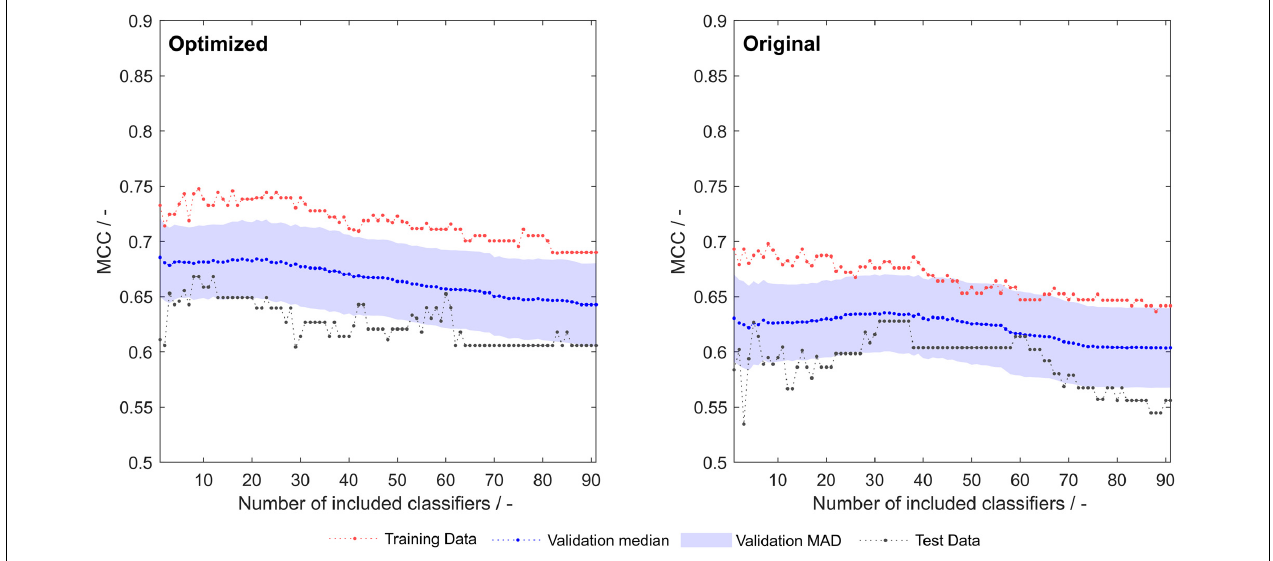
FIGURE 5 | Training, validation and test sets Matthew’s correlation coefficient (MCC) of optimized (left) and original (right) 91 literature hydrophobicity scales. The shaded area represents the median absolute deviation (MAD) during 1000-fold Monte Carlo